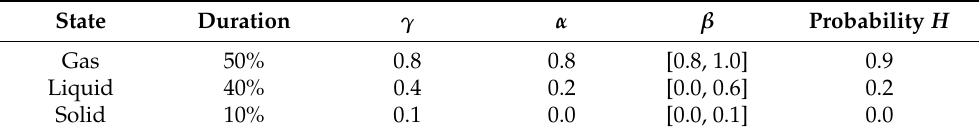
Table 1. Parameter settings of the SMS